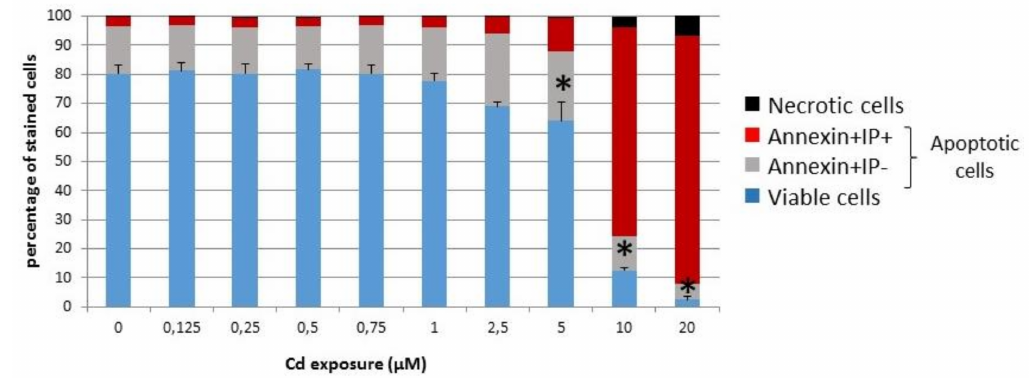
Figure 1. Viability of INS-1 cells in the presence of cadmium. The fractions of viable and death committed cells after 72 h of cadmium exposure were measured by flow cytometry after FluoProbe 488-Annexin V and PI labeling. Only above 2.5 µ M was the fraction of viable cells significantly altered. * ANOVA test for live cells p < 0.05 vs. 0 µ M Cd 2+ ( n =